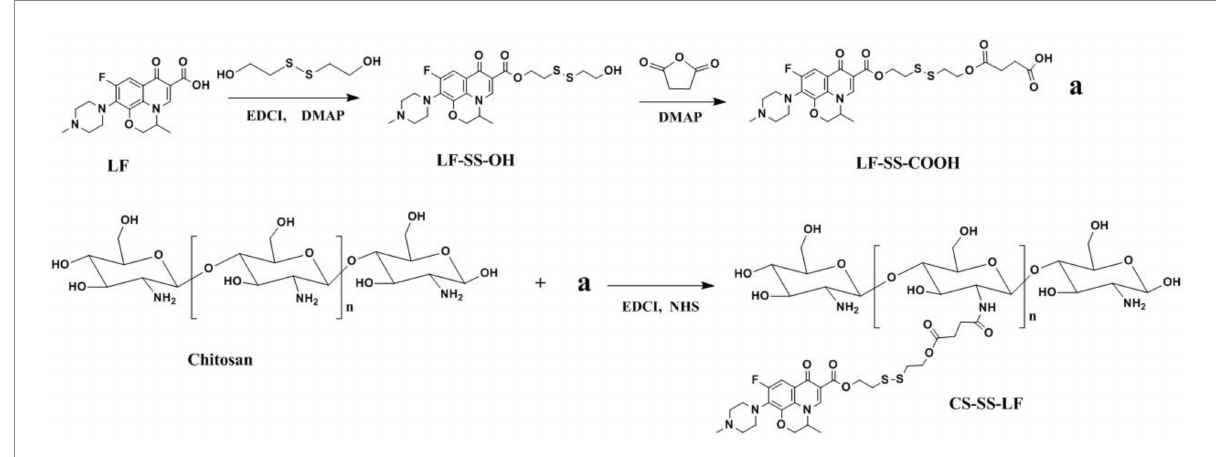
FIGURE 2 A synthetic route for CS-SS-LF